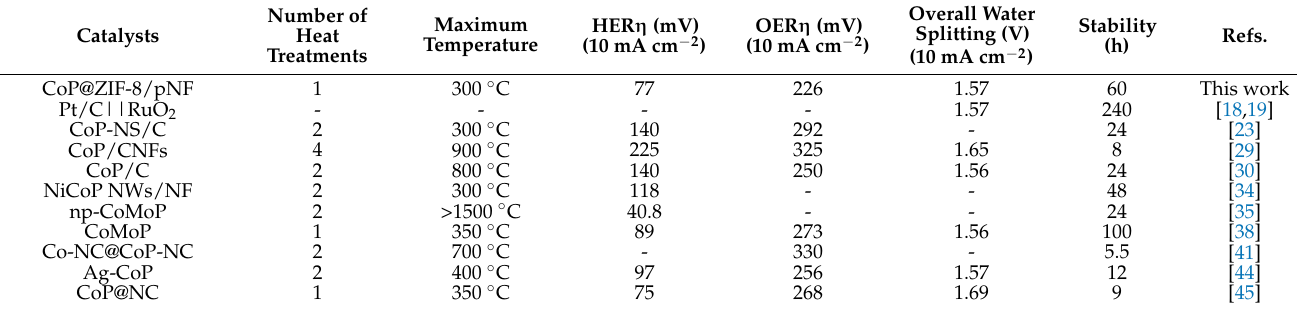
Figure 10. ( a ) Overall water splitting LSV curves of CoP@ZIF-8/pNF (+|| − ), CoP@ZIF-8/NF (+|| − ), CoP/pNF (+|| − ) and bare NF (+|| − ). ( b ) Stability test of water splitting at a constant current density of 10 mA cm − 2 when using CoP@ZIF-8/pNF as an electrode, and SEM images of the anode and cathode after the stability test. Table 1. Comparison of the performance of different electrocatalysts.